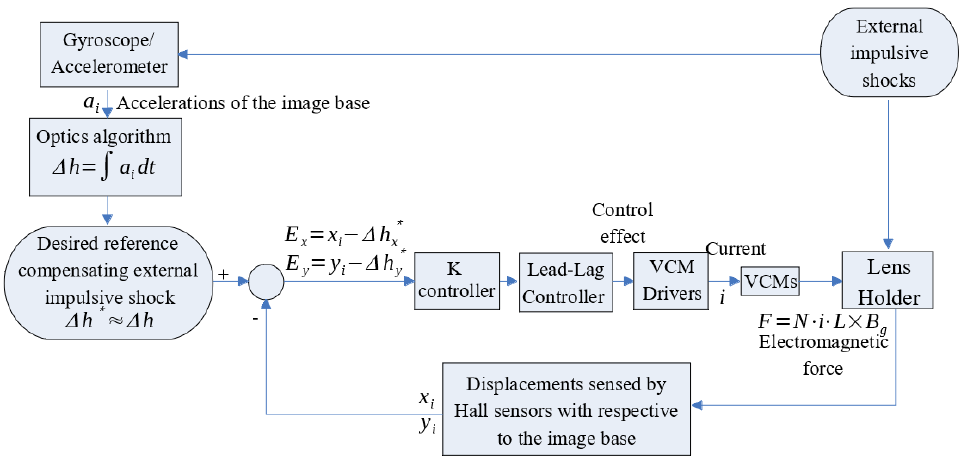
Figure 5. The closed-loop control system of the OIS.